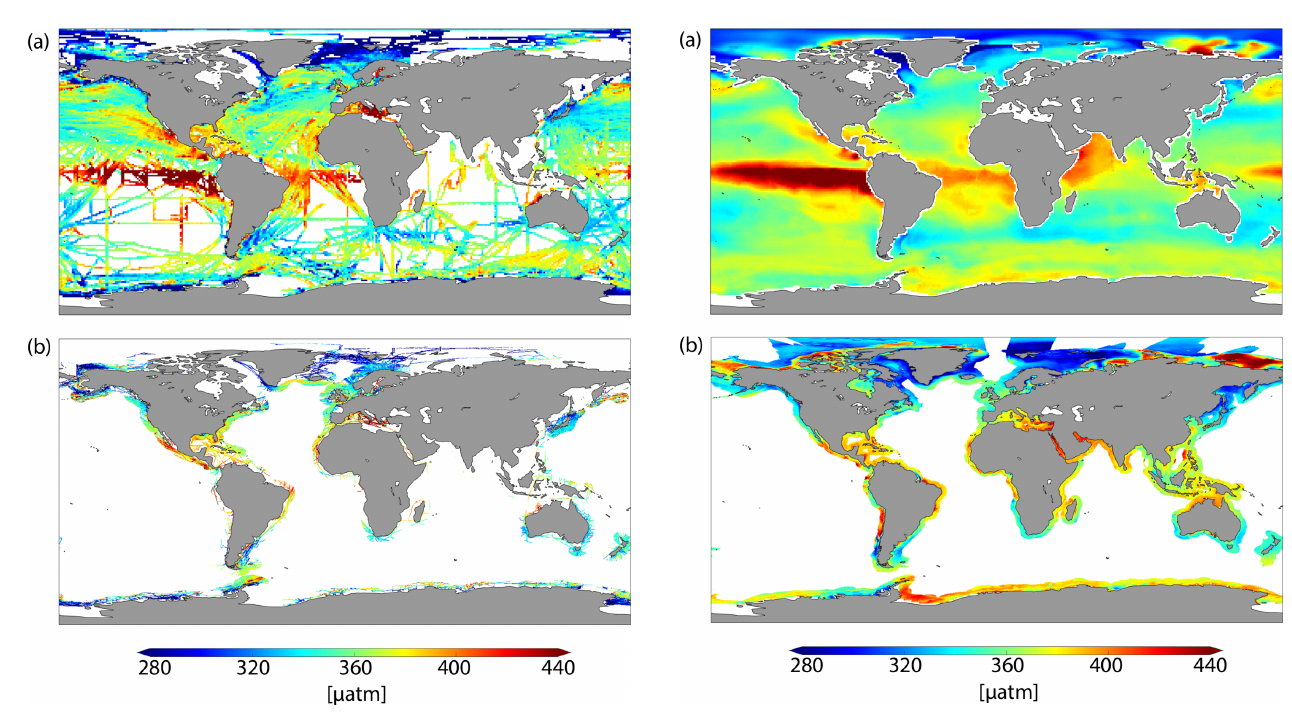
Figure 1. Gridded (a) 1 ◦ × 1 ◦ open-ocean and (b) 0 . 25 ◦ × 0 . 25 ◦ coastal-ocean p CO 2 data values extracted from the SOCATv5 database from 1998 through 2015. Each value on the maps repre- sents the mean of all values available within each grid cell for the period considered.